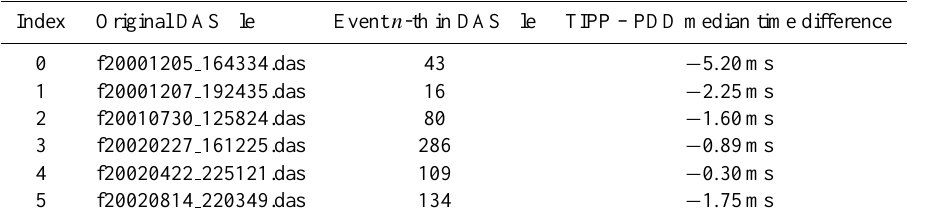
Table 4. Filter # 6 HUMR events.